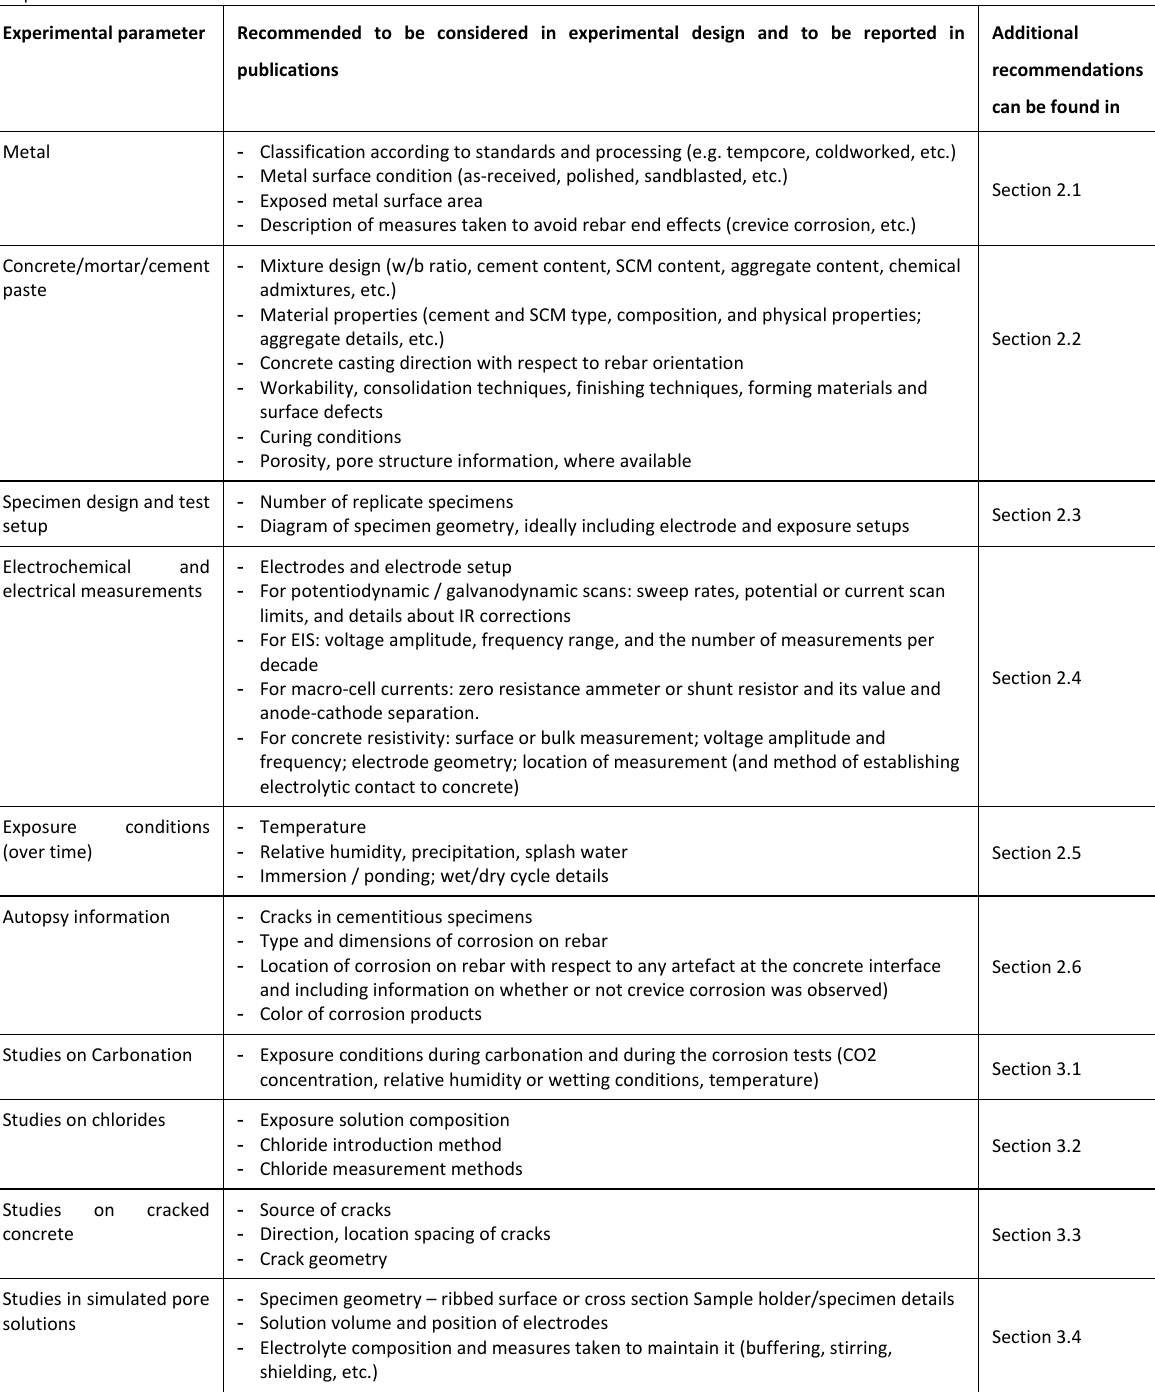
Table 1 . Checklist of critical considerations in the design of corrosion experiments in cementitious materials to be documented in scientific reports and publications. Experimental parameter Recommended to be considered in experimental design and to be reported